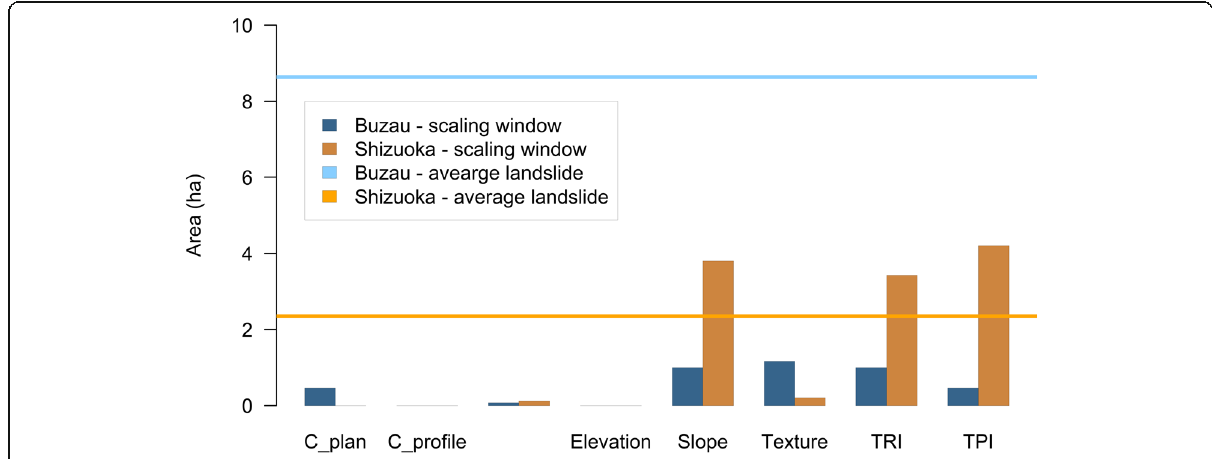
Fig. 9 A comparisons between the area that scaled variables represent (bars) and the average area of landslides (horizontal lines)